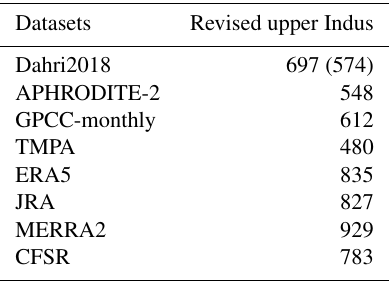
Table 5. Mean annual precipitation (in mm) for various datasets over the study area defined in Dahri et al. (2018) for the pe- riod 1999–2011. Both adjusted and unadjusted values (the latter in parenthesis) from Dahri et al. (2018) are reported in the second